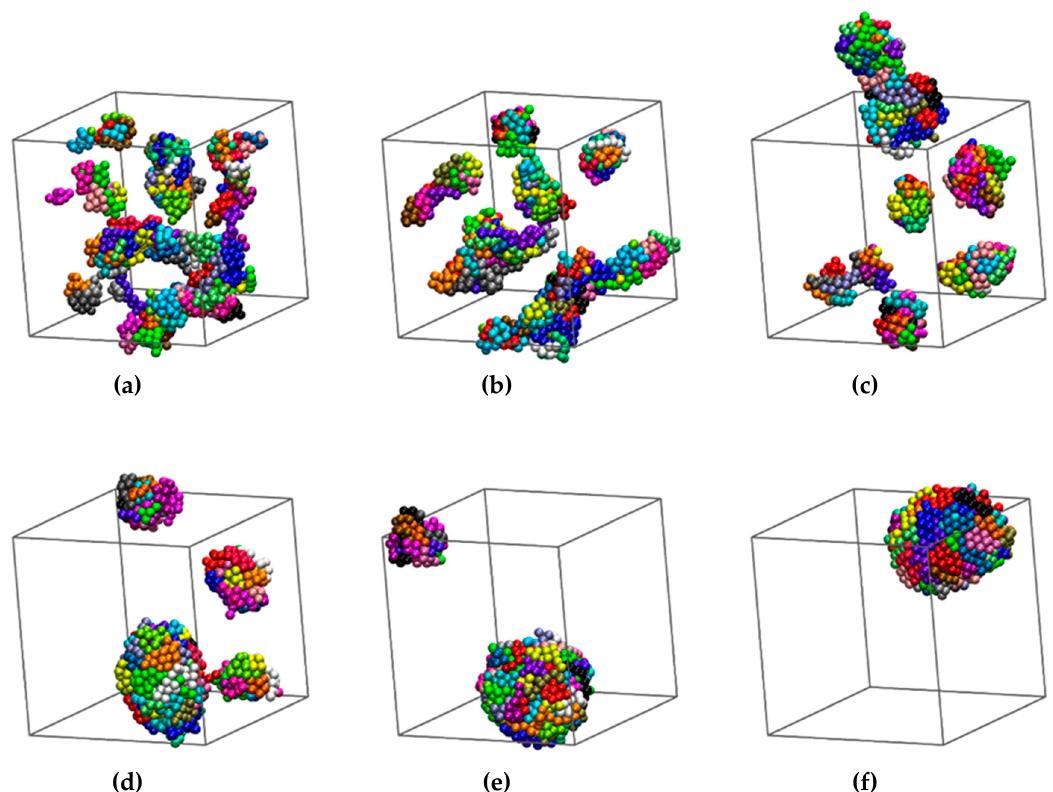
Figure 2. Snapshots of system configurations as simulation evolves for chains interacting with the square well potential ( ε = 1.0 and σ 2 = 1.2) at ( a ): 10 5 [16], ( b ) 10 6 [8], ( c ) 10 7 [7], ( d ) 10 8 [4], ( e ) 10 9 [2] and ( f ) 1.4 × 10 12 (end of simulation) [1] MC steps. Numbers in square brackets denote the number of distinct clusters. Monomers are color-coded according to their parent chain. Spheres of each cluster are shown in unwrapped coordinates. 3-D, interactive versions of the figure panels exist in supplement material (as well as a 3-D, interactive version of the present manuscript).